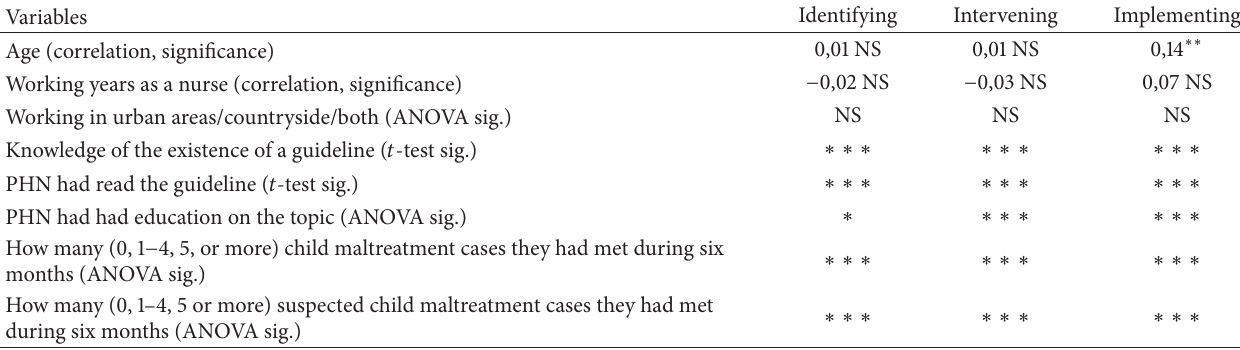
Table 5: Estimated unstandardized regression coefficients for all variables from linear regression models, separately for identifying, intervening , and implementing ( 𝑁 = 367 ). Model